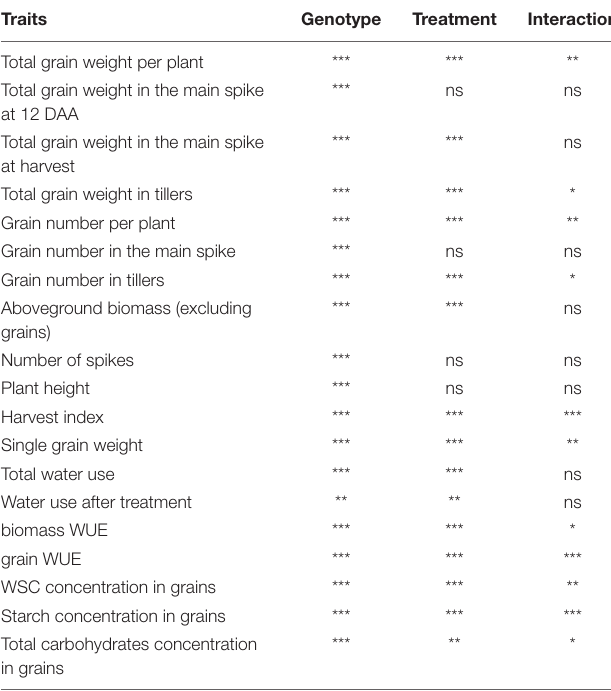
TABLE 1 | Analysis of variance (ANOVA) showing the statistical significance of the traits measured for genotype, treatment and interaction between genotype and